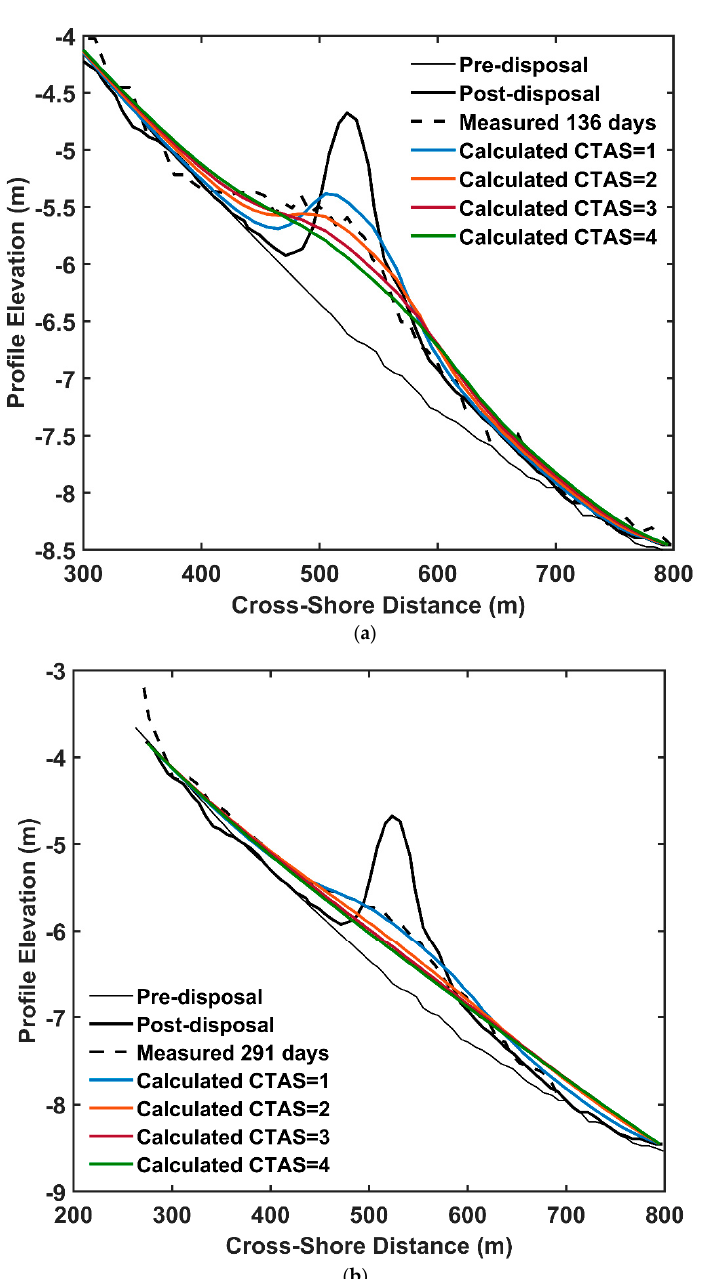
Figure 6. ( a ) The evolution of the mound after 136 days in response to changes in the values of the parameter CTAS used as a multiplier for the bed load sediment transport rate. ( b ) The evolution of the mound after 291 days in response to changes in the values of the parameter CTAS used as a multiplier for the bed load sediment transport